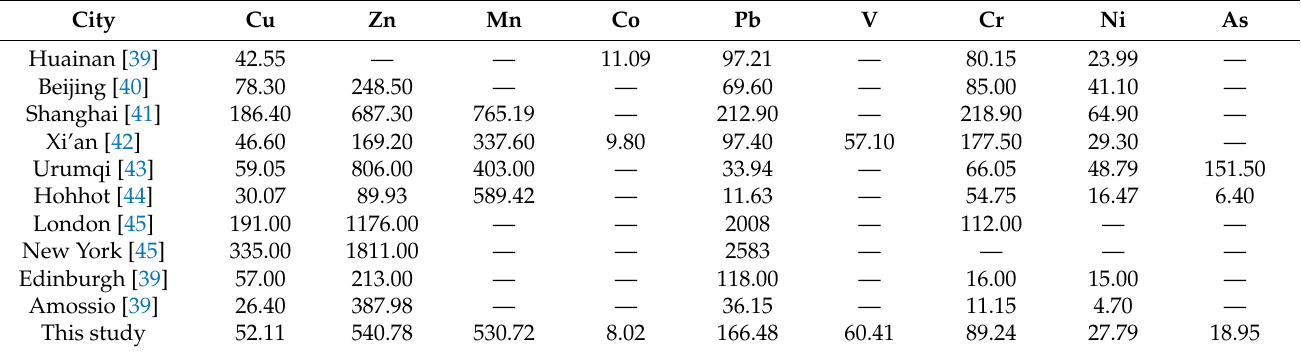
Table 2. A comparison of heavy metal contents in the dust of different cities